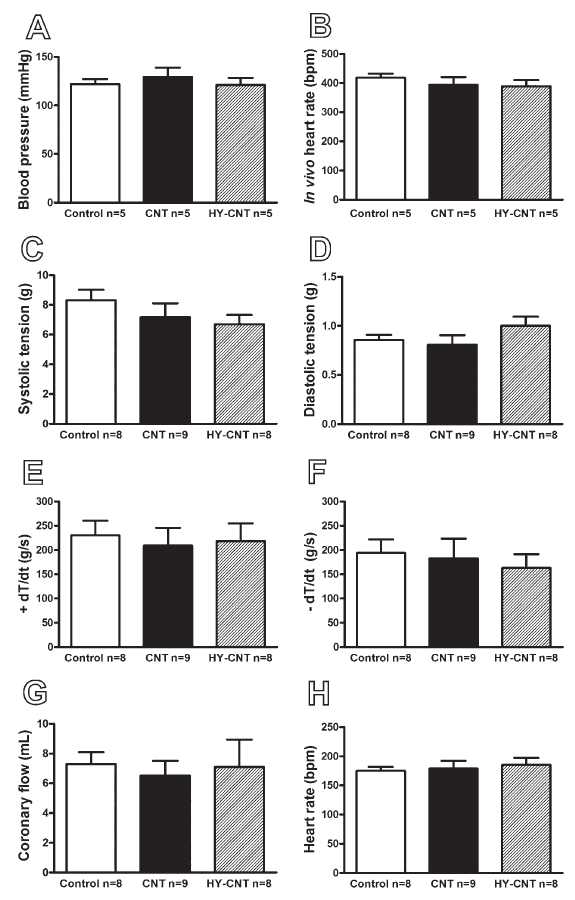
Figure 2. Effects of carbon nanotubes (CNTs) and CNTs associated with sodium hyaluronate (HY-CNTs) on mean arterial pressure (MAP), heart rate (HR) and cardiac function adminis- tered to tooth sockets. A , MAP; B , in vivo HR; C , systolic tension; D , diastolic tension; E , ++dT/dt; F , ––dT/dt; G , coronary flow; H , ex vivo HR; ±dT/dt: rates of contraction and relaxation. Data are reported as means±SE. There were no significant differences among groups (P . 0.05; one-way ANOVA followed by Newman- Keuls